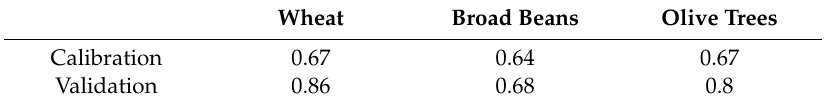
Table 3. R 2 coe ffi cient values during calibration and validation of plant growth module of SWAT. Table 3. R 2 coefficient values during calibration and validation of plant growth module of SWAT. Wheat Broad Beans Wheat